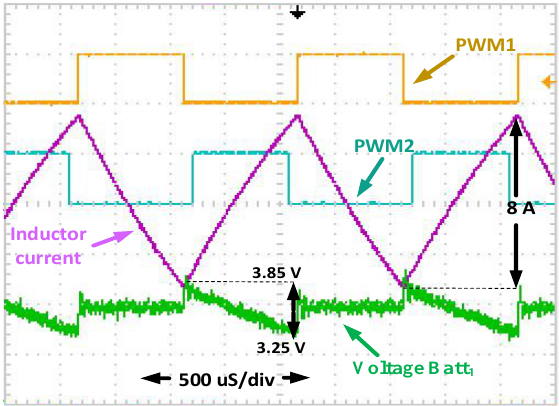
Figure 9. The waveform of the preheating mechanism for 1 kHz. Figure 10 explains the experimental waveforms of LC resonant tank conditions. In this mode, the battery is injecting current into the LC resonant tank, and oscillation occurs at the resonant frequency. The peak current and voltage of the oscillation at the resonant frequency are measured, and the resistance can be calculated from (3 and 7). dSPACE DS1104 is utilized to track the peak and the mean of the current and voltage. Through this, FFT and additional data processing are not needed. Moreover, the LC resonant tank can keep the resonant frequency stable at 56 Hz as a resonant frequency of Lr = 1.4 mH, Cr = 5600. The LIB voltage and current are in phase, with a peak of 3.92 V (or 0.56 V from the rated 2.8 V) and 1.5 A.